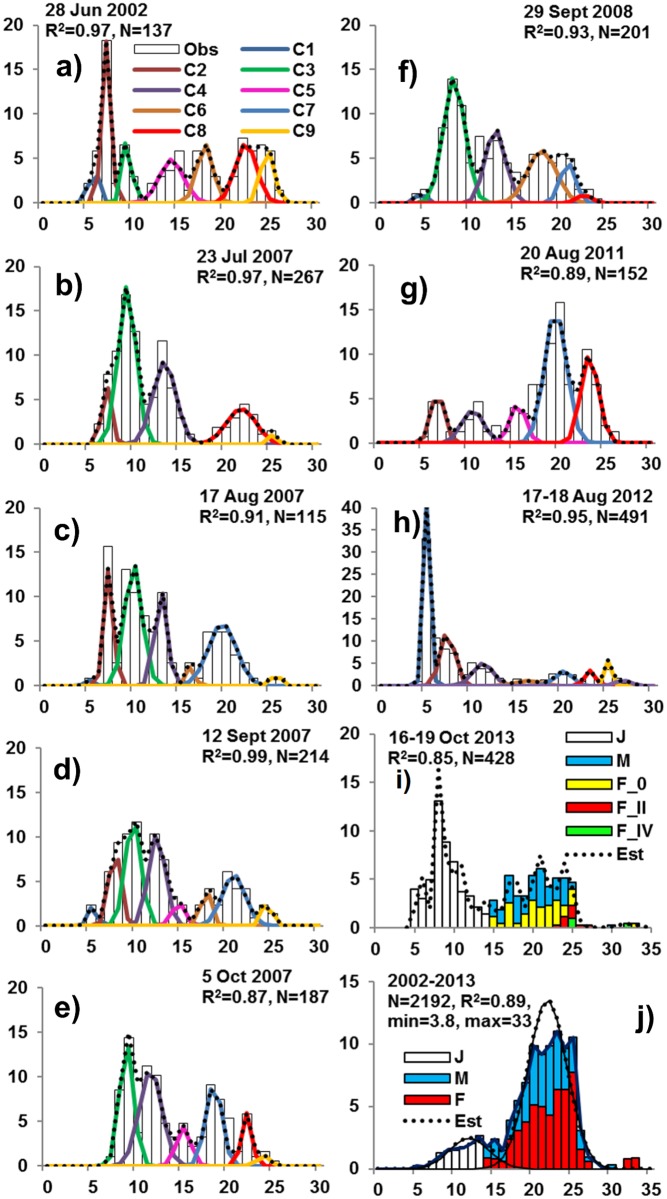
Relative cohort densities or biomass among years and months.Including (C1-C9) densities m-2 among 1 mm length frequencies of the 2002–2013 sampling dates (a-i) and the proportion of average biomass m-2 for all years (j) with number of specimens (N), observed frequencies (vertical bars), predicted frequencies (dashed lines), regressions of predicted and observed frequencies and example of juvenile and adult reproductive development and sex ratios in (i).